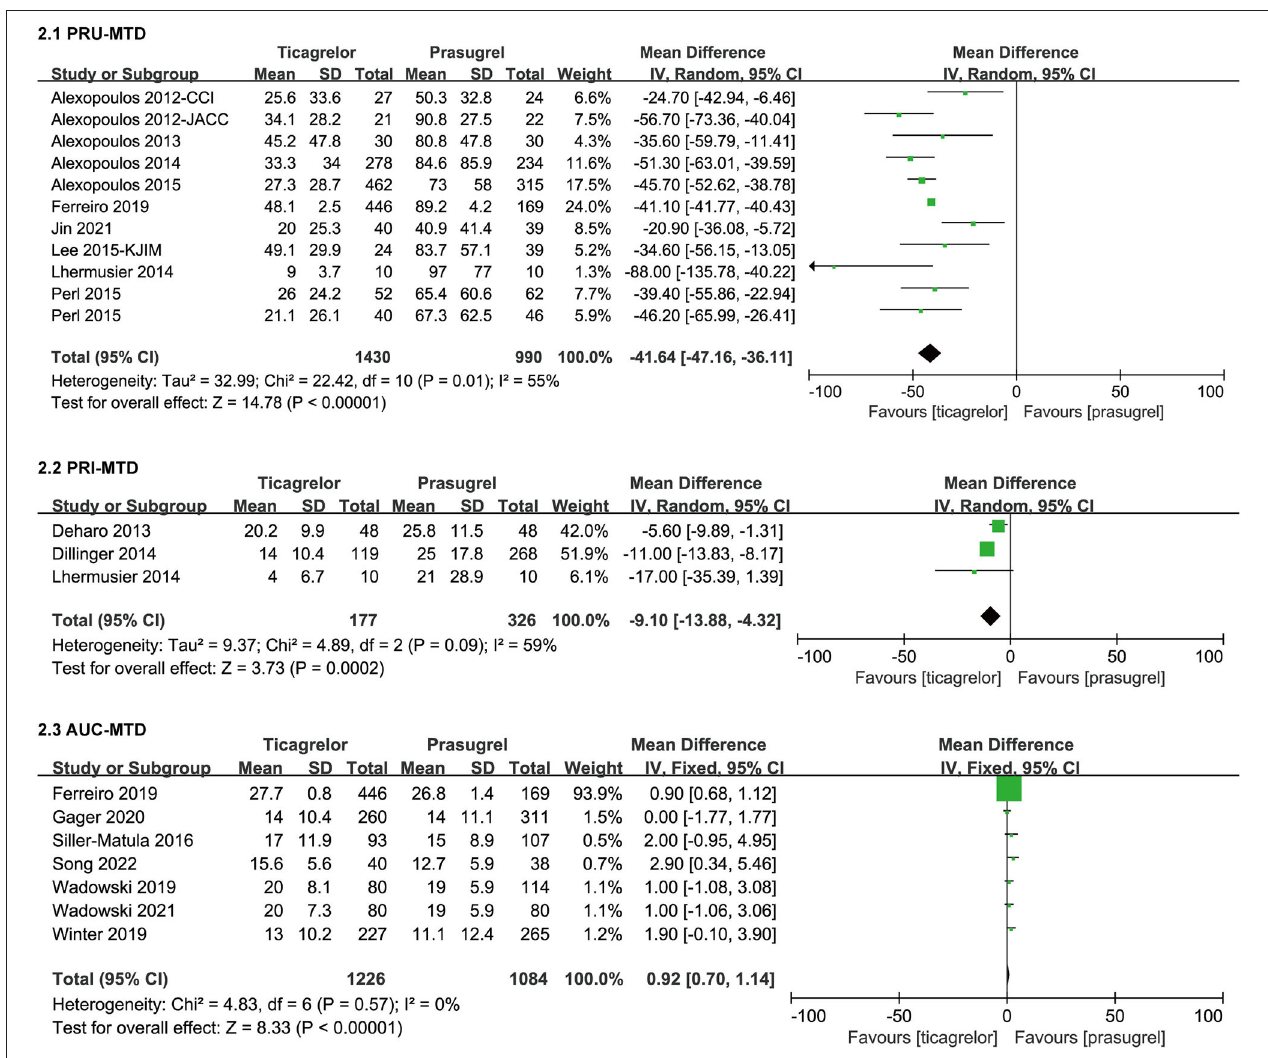
FIGURE 5 | Forest plots of meta-analysis results of PR after